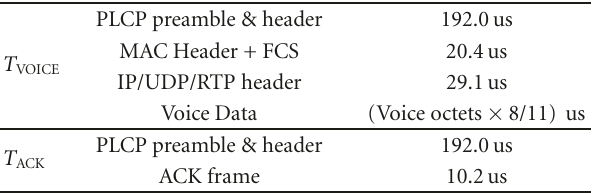
Table 3: Component times of T VOICE and T ACK for 11Mbps data